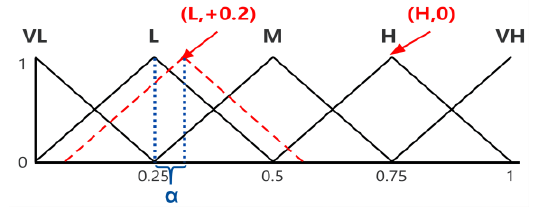
Figure 3. Representation of 2-tuple values.